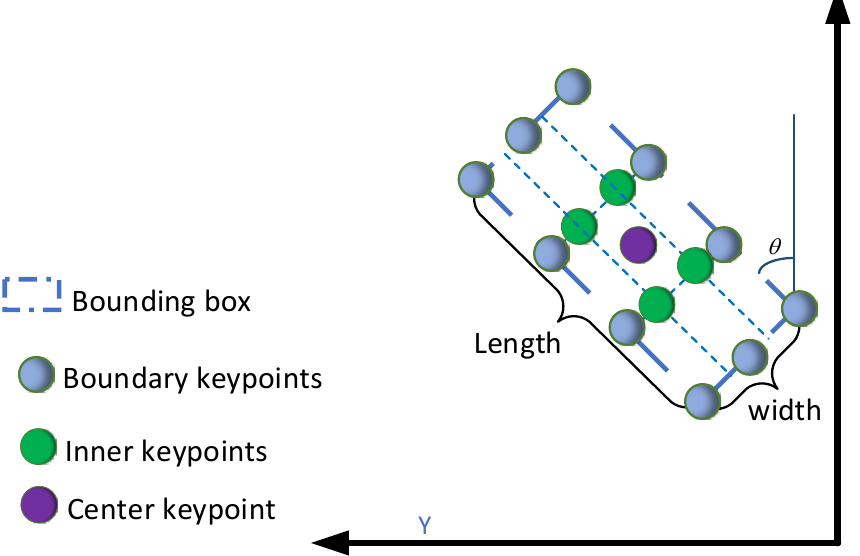
Figure 7. The method to calculate keypoints. The boundary keypoints are represented by blue circles and the inner points by green circles. The center keypoint is indicated by a purple circle. The blue dashed line refers to the BEV of the predicted bounding box.